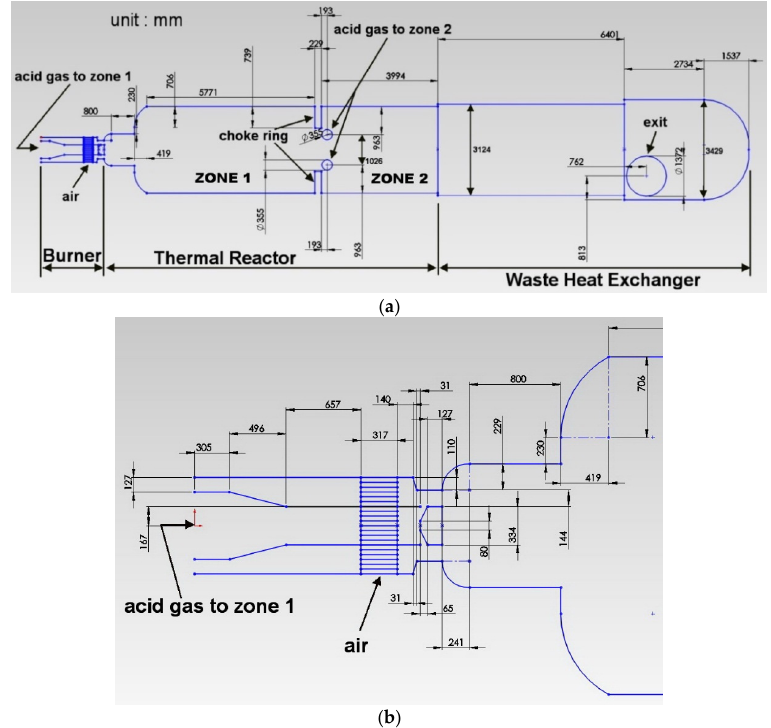
Figure 1. The configuration and dimensions of the first section of the SRU for a typical petroleum refinery: ( a ) The overall view; ( b ) Enlarged view for the burner